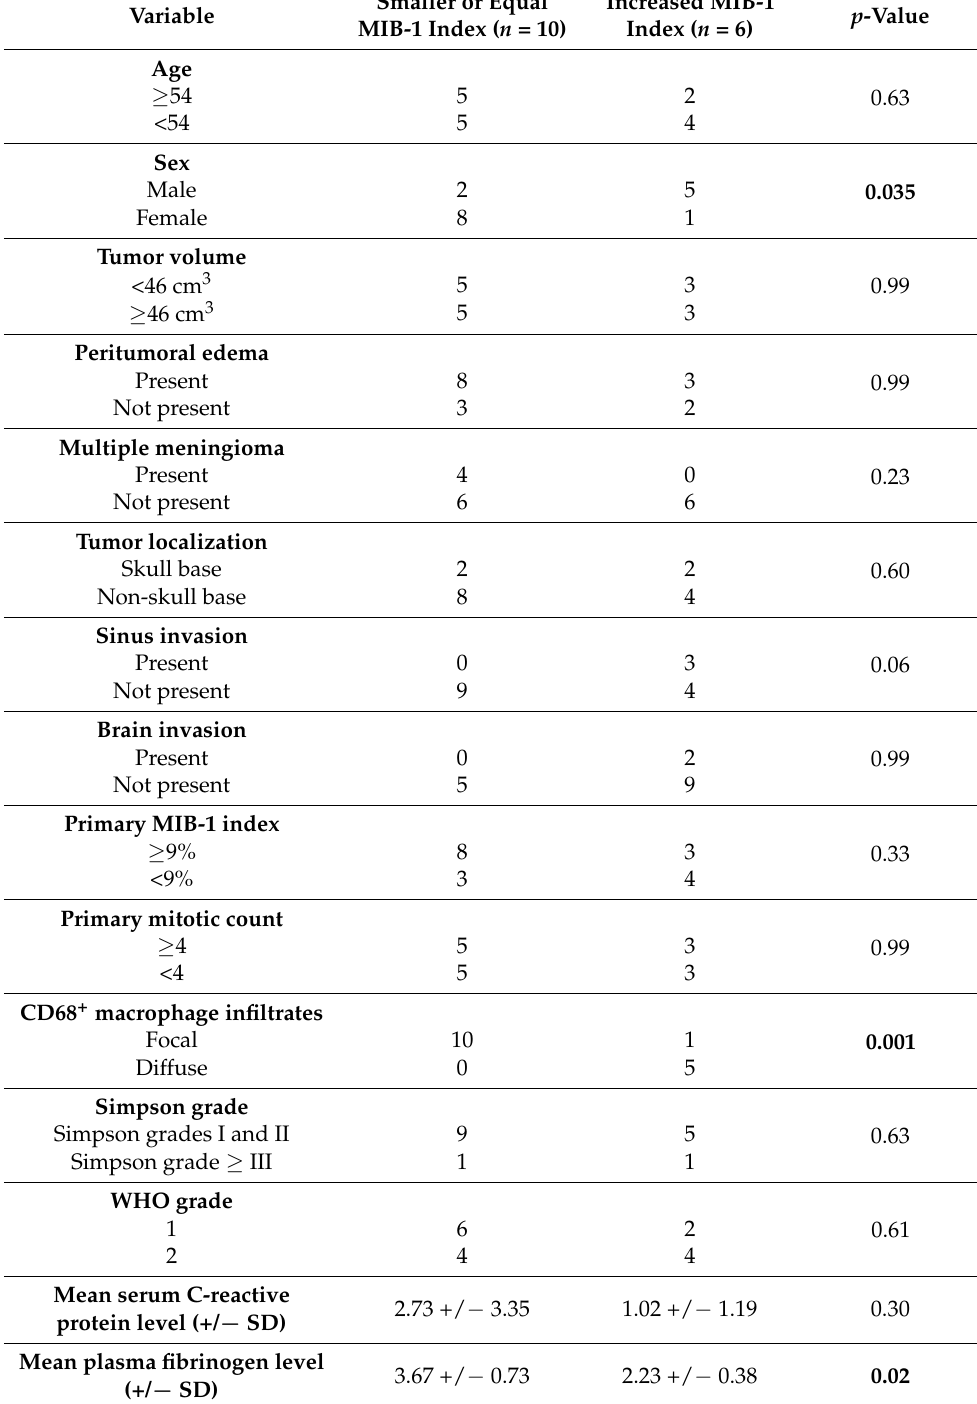
Table 4. Association between the baseline clinical, imaging, histopathological features and intra- individual MIB-1 labeling index differences in primary and recurrent meningiomas. Significant results ( p < 0.05) are shown in bold